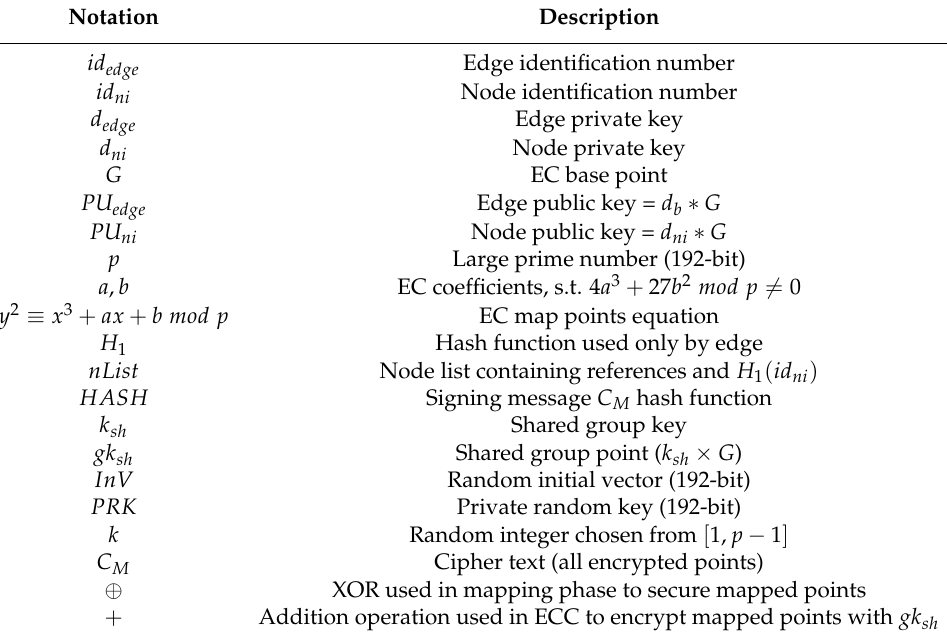
Table 1. Notation relevant to the proposed scheme.